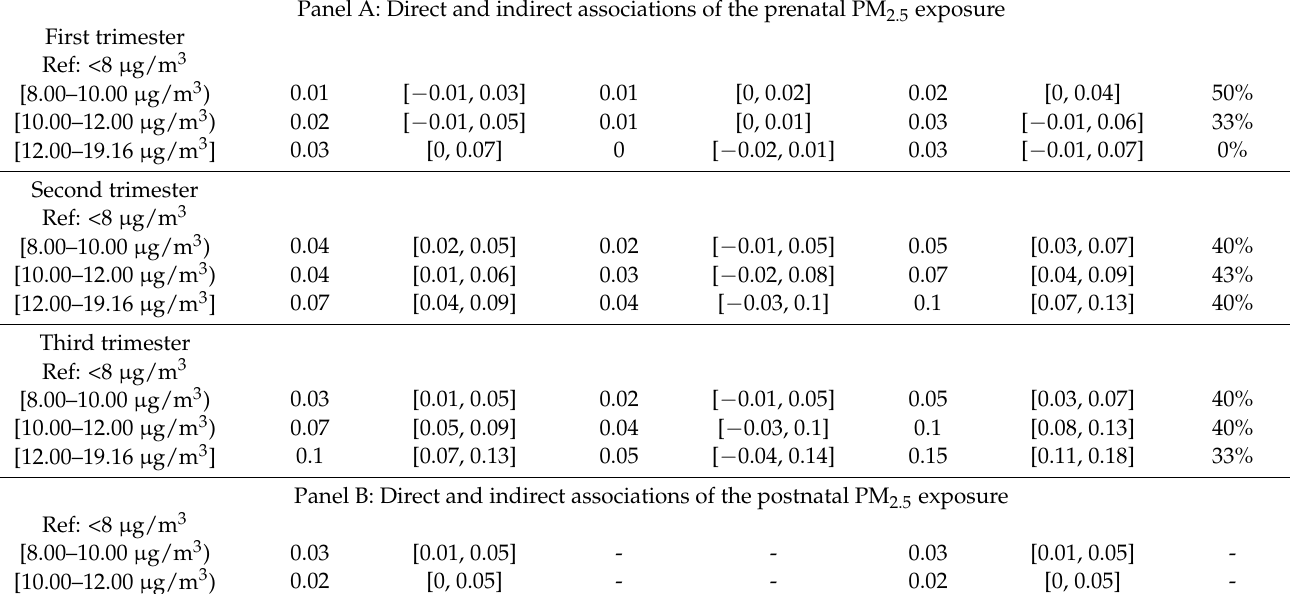
Panel A: Direct and indirect associations of the prenatal PM 2.5 exposure